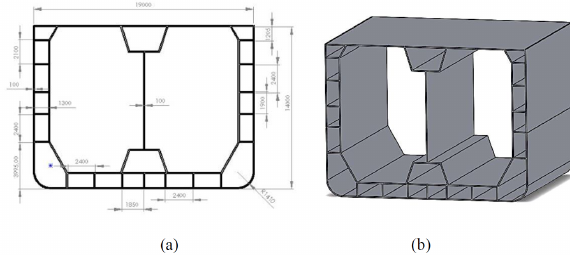
Figure 5: (a) Geometry of the midship section and (b) 3D model of the midship.